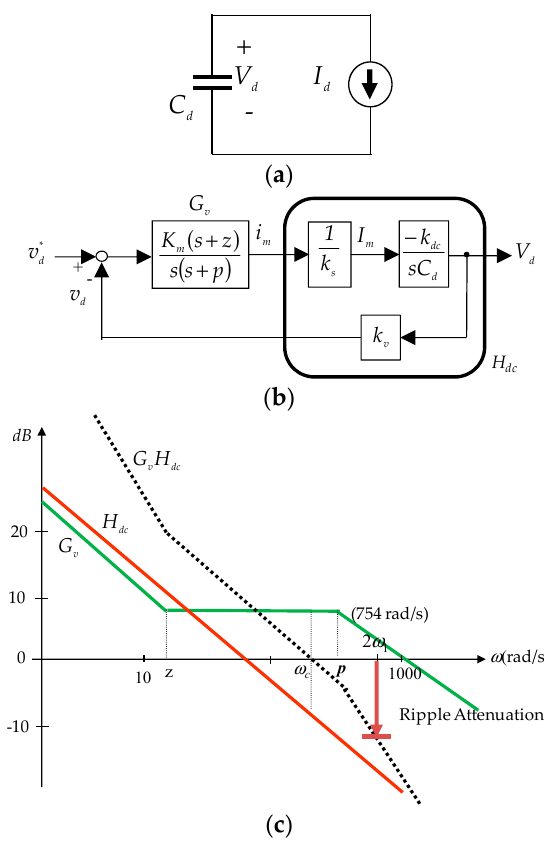
Figure 3. Conventional DC bus voltage controller for inverter: ( a ) small signal model of inverter viewed from the DC side; ( b ) DC bus voltage control loop; ( c ) bode plot of control loop transfer functions.